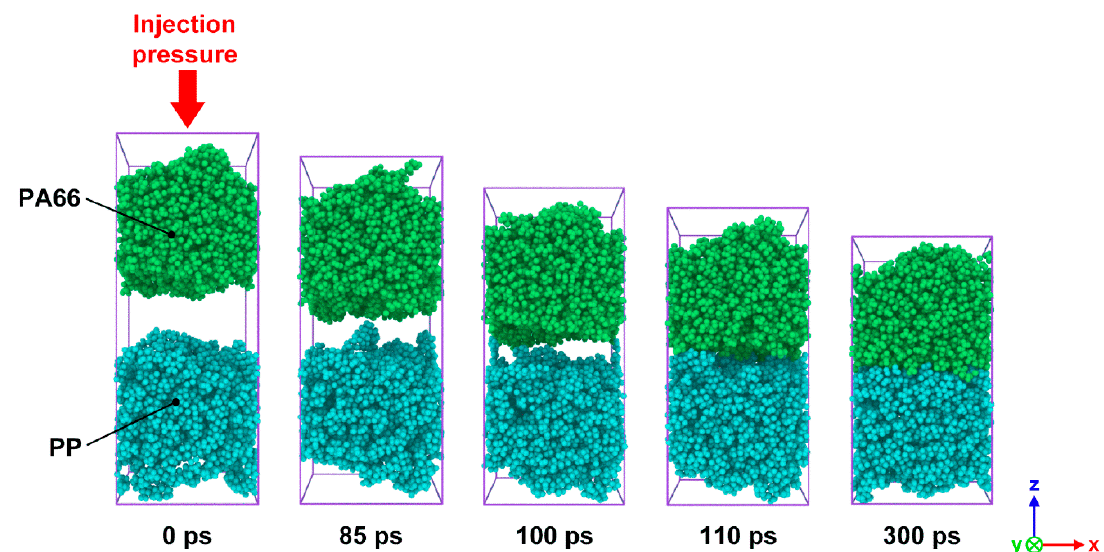
Figure 3. Snapshots of the bonding process of SFR-PA66 and CFR-PP under the processing parameters of T p = 180 °C , T m = 280 °C and P = 4 MPa at simulation times of 0, 85, 100, 110 and 300 ps.